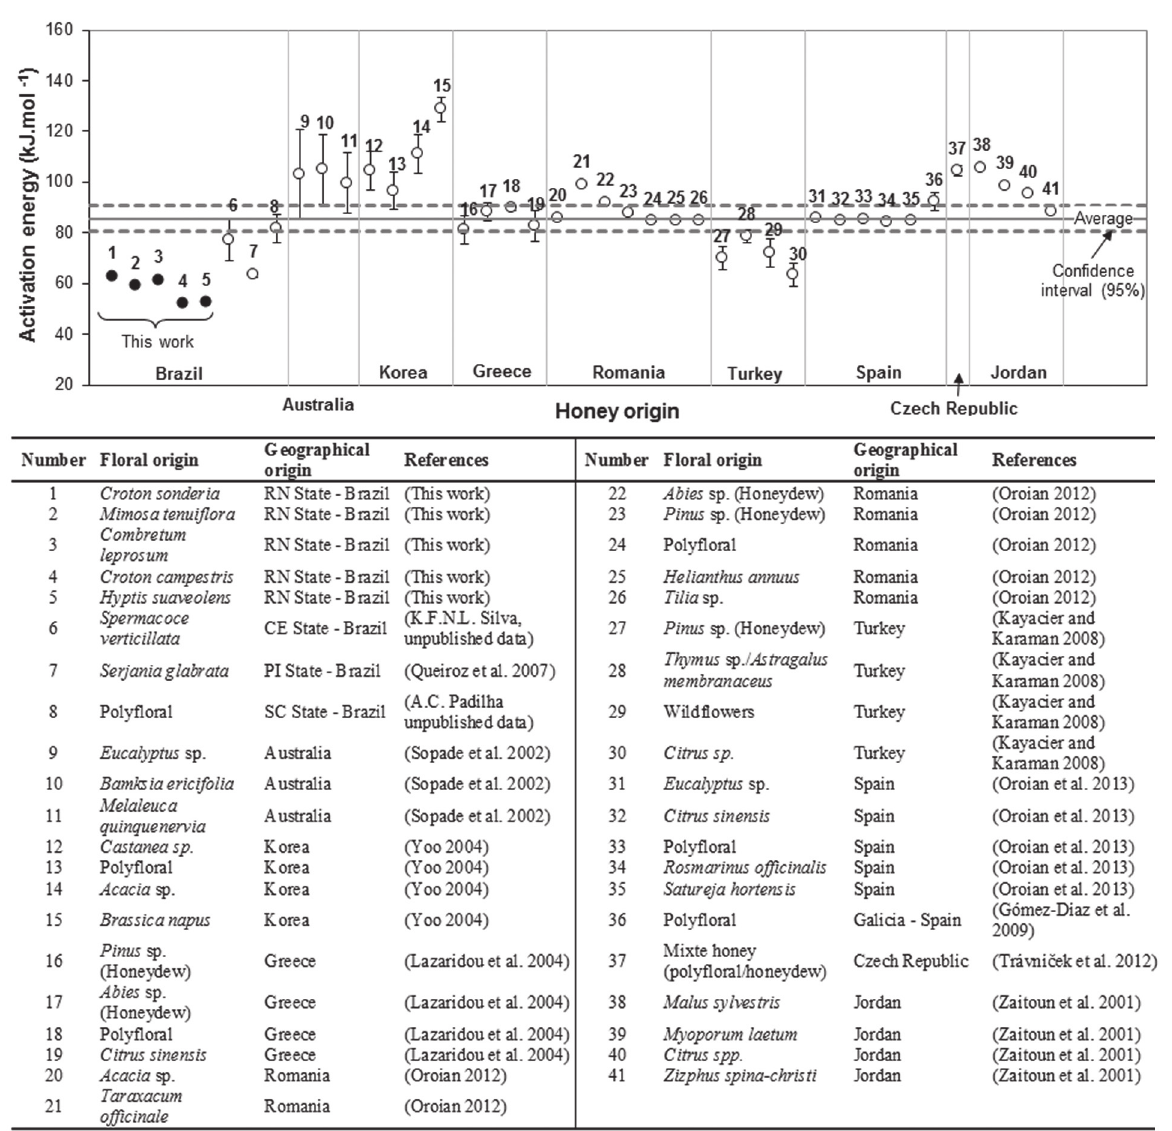
Figure 5 - Activation energies of honeys from different geographical and floral origins as reported by some authors (The dots mean the average of activation energies of the honeys and the bars errors are standard deviations. The bars errors do not appear when standard deviations were too small or they were not reported by